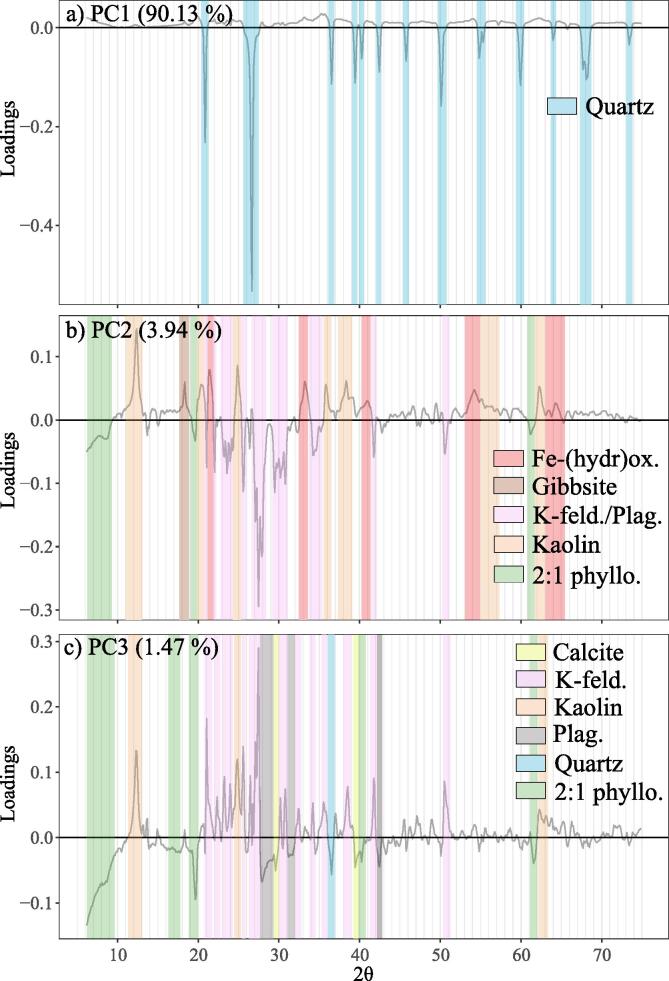
The loadings of PC1 (a), PC2 (b) and PC3 (c) from PCA of the pre-treated and subset (n=239) XRPD data (Section 3.2.3). Highlighted regions represent the soil minerals associated with that specific region of XRPD variables.